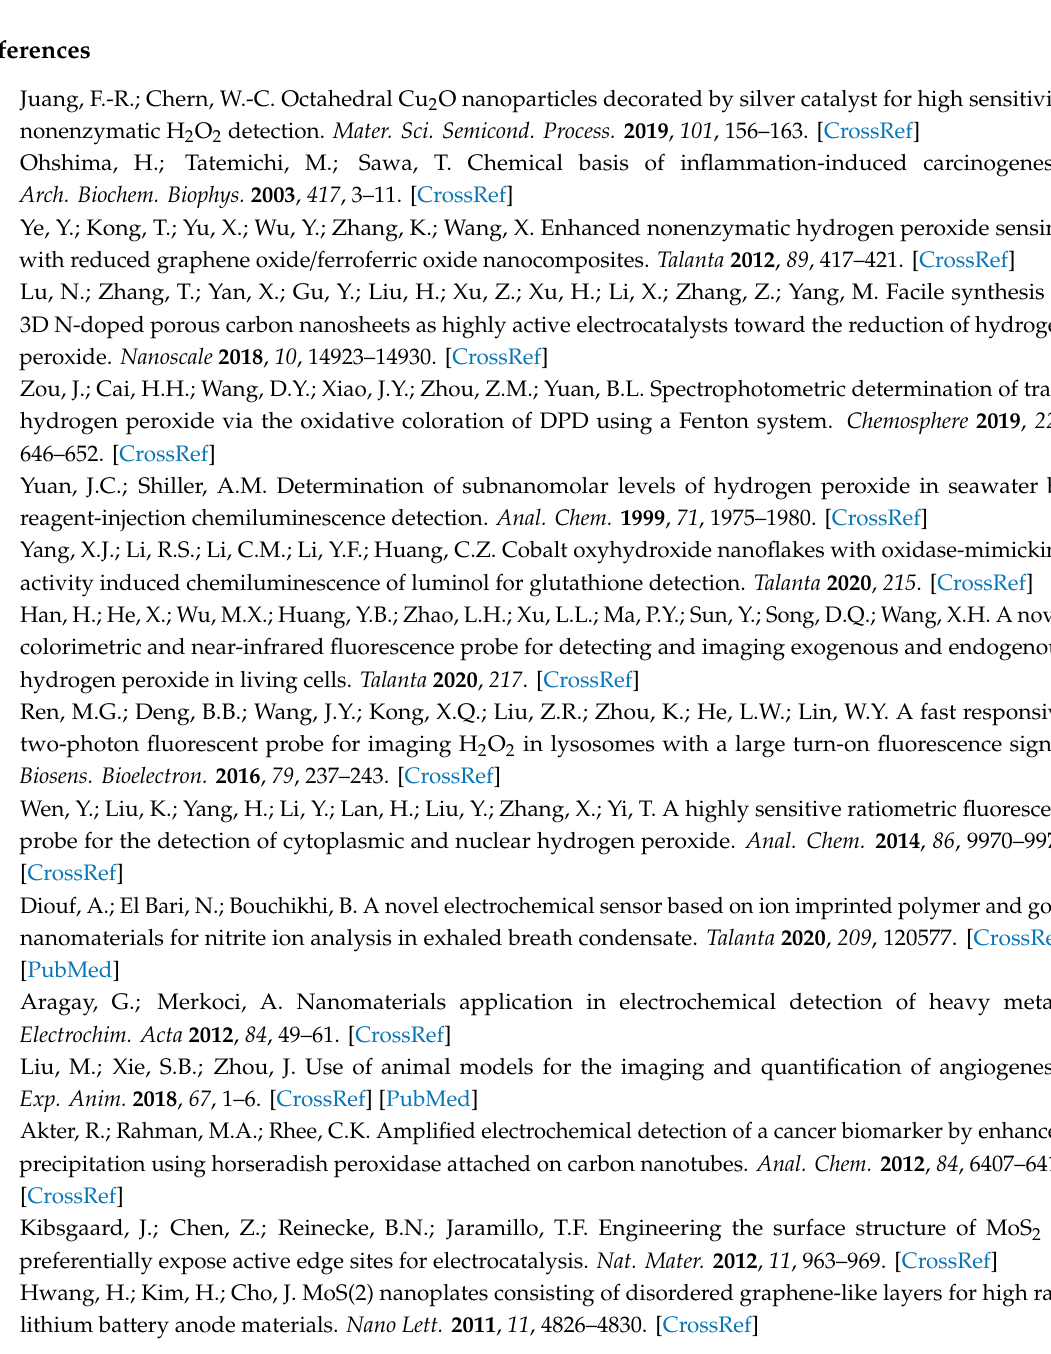
Figure S1: XPS survey spectrum of MoS 2